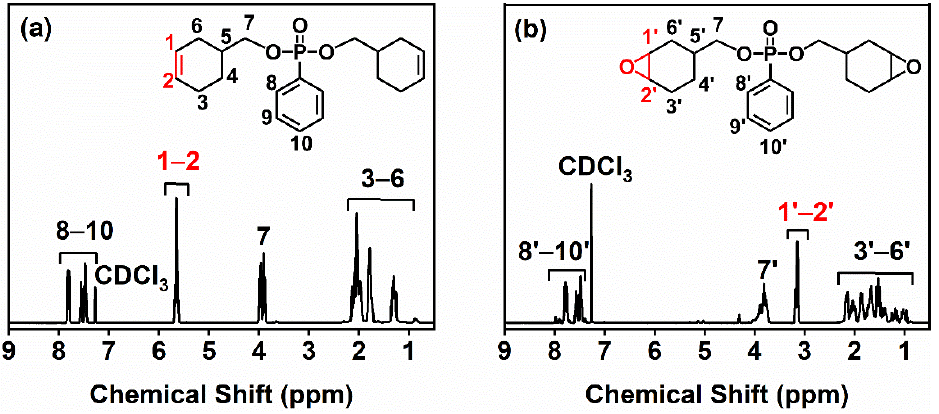
Figure 1. 1 H NMR spectra of BCP ( a ) and BCEP ( b ).